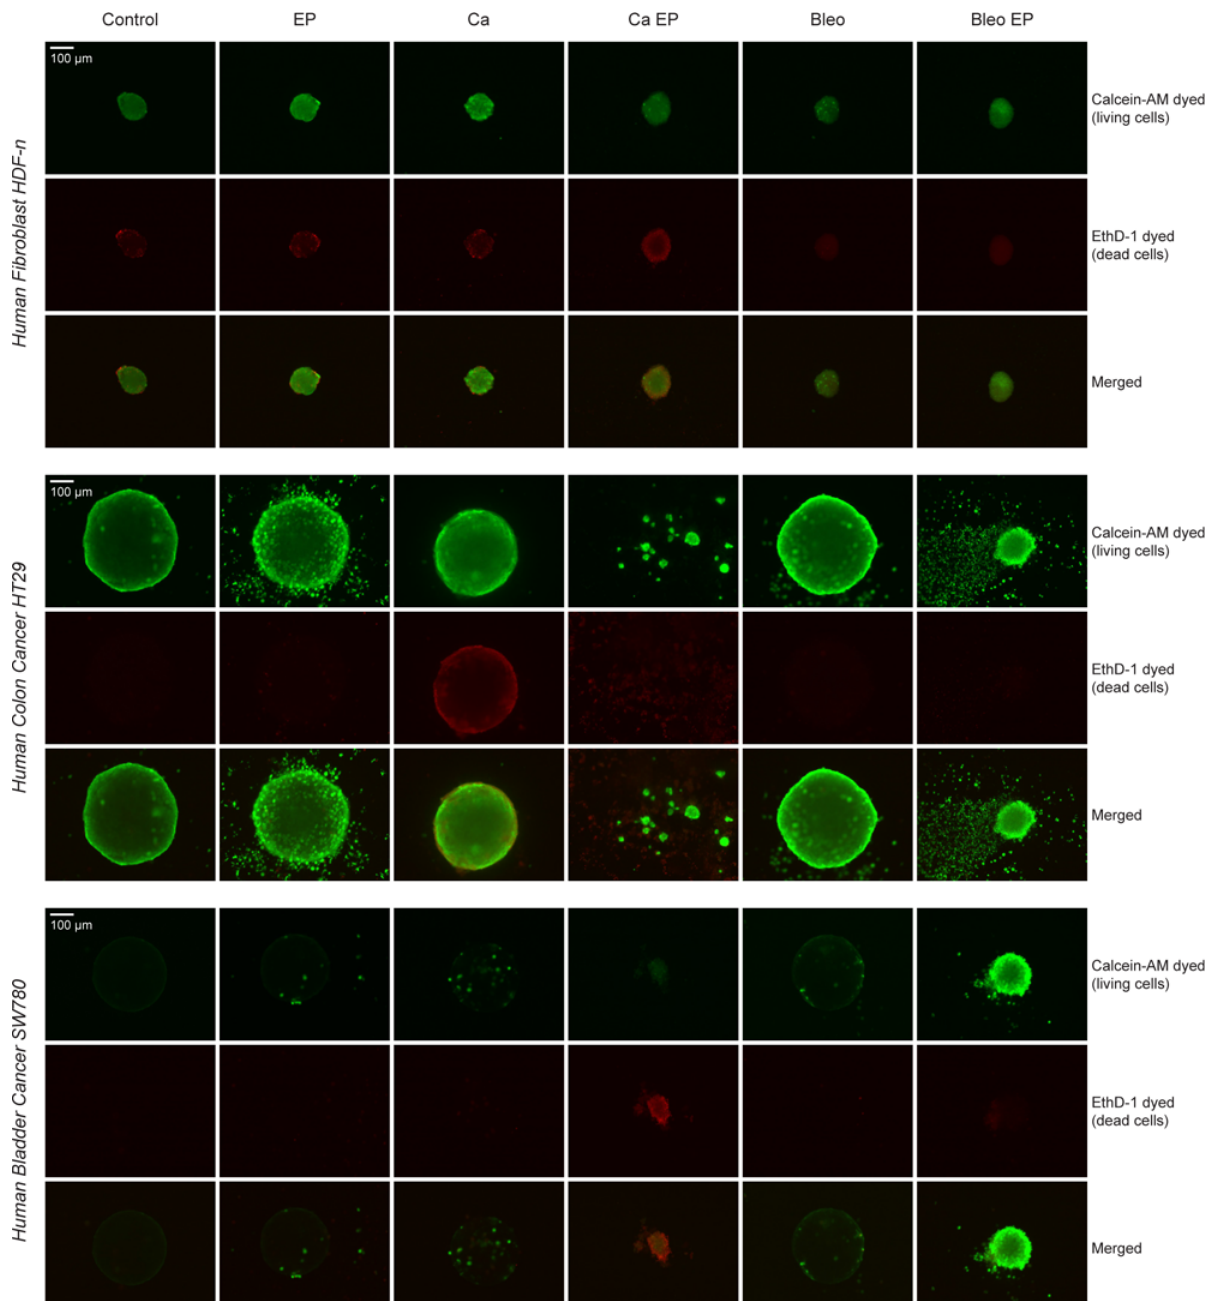
Fig 2. Live/dead staining. Live/dead staining with Calcein-AM and EthD-1 of human normal dermal fibroblast, colon cancer, and bladder cancer spheroids 4 days after treatment with 168 mM calcium (Ca), 1 mM bleomycin (Bleo), electroporation (EP; 8 pulses of 100 μ s, 1000 V/cm, and 1 Hz), 168 mM calcium electroporation (Ca EP), or electrochemotherapy using 1 mM bleomycin (Bleo EP), and of untreated controls (Control). Upper panels are calcein-AM staining (living cells), middle panels are EthD-1 staining (dead cells), and lower panels are merged images of living (green) and dead (red)